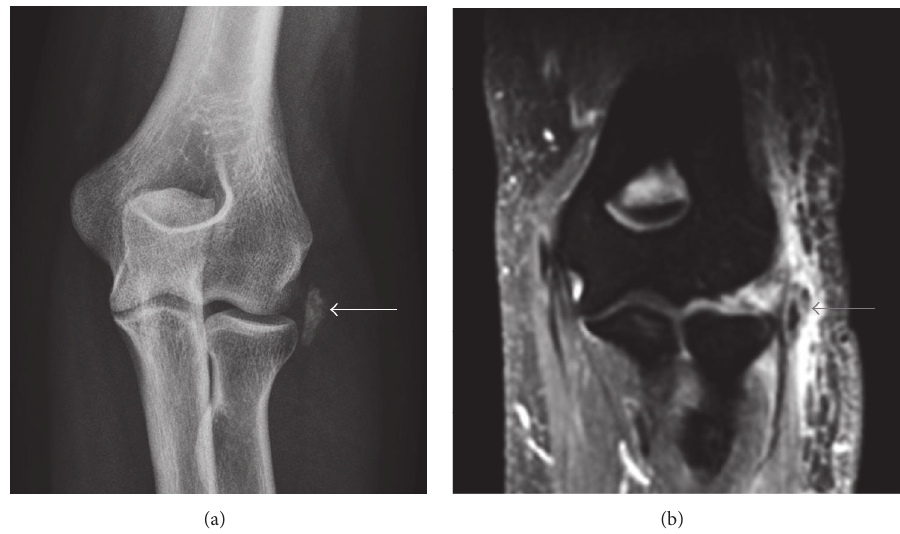
Figure 10: Calcific tendinitis of the common extensor tendon origin. (a) AP radiograph shows amorphous calcifications along the lateral aspect of the elbow joint (white arrow). (b) Exuberant soft tissue edema can be seen around the calcifications, which are centered within the common extensor tendon (grey arrow).